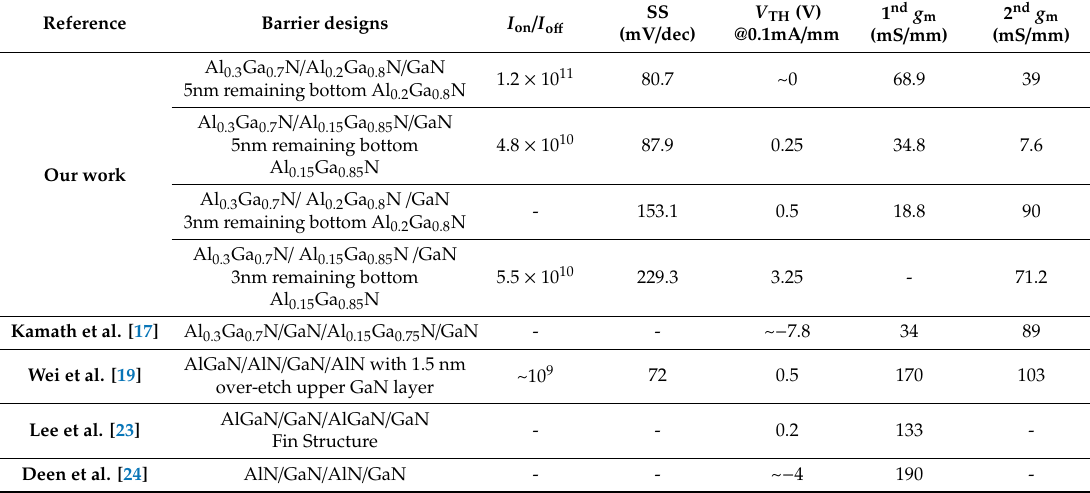
Table 2. Reference for the double channel GaN